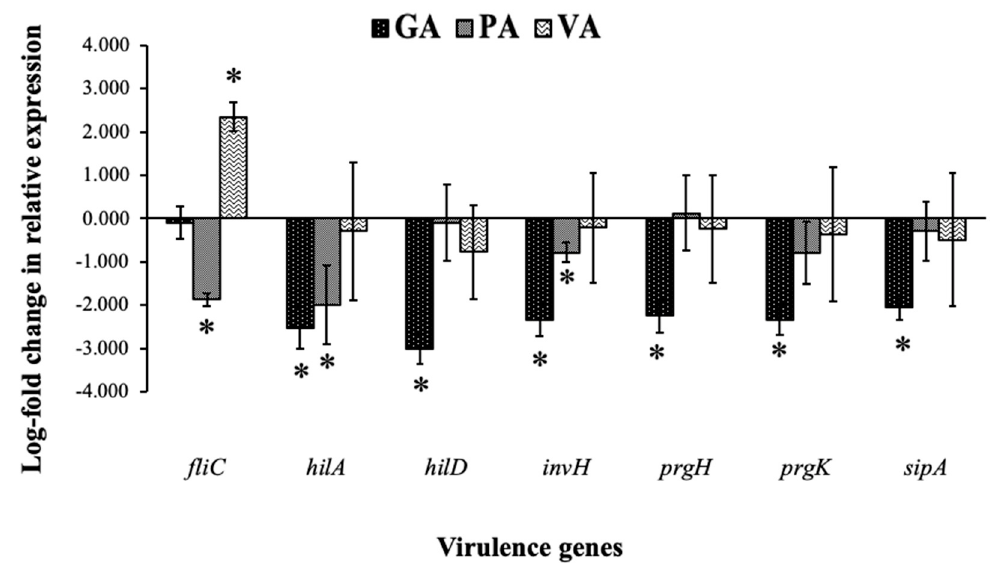
Figure 6. Evaluation of log-fold changes of ST virulence genes through measurements of relative gene expression. Significant difference in treatment as compared to control ( p < 0.05) was denoted with an asterisk (*).